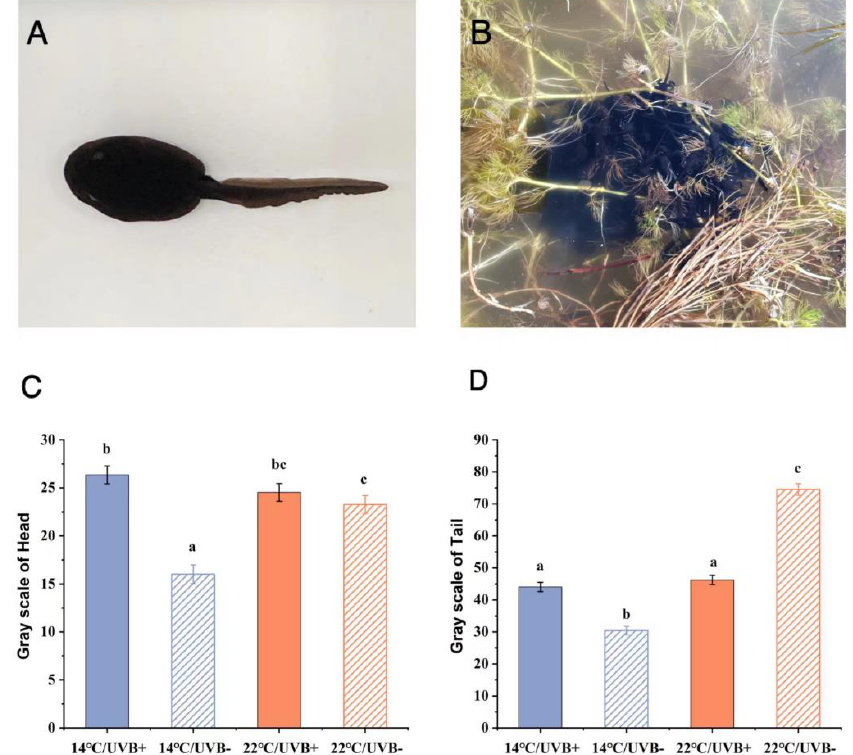
Figure 7. ( A ) Rana kukunoris tadpole in Stage G30. ( B ) Aggregation behavior of Rana kukunoris tad- poles in a wild pond. ( C , D ) Effect of UVBR (solid bars) and UVBR – free (patterned bars) environ- ments in combination with a 14 (blue bars) or 22 °C (red bars) temperature on the grayscale value of the head ( C ) and tail fin ( D ), respectively. Data are presented as means ± standard error. Lower- case letters above bars denote significant differences between groups. The color of the tadpole is expressed by grayscale, with a smaller gray value representing a darker body color. The grayscale value of both the head and the tail fin in the 14 °C/UVBR – free groups was significantly lower than that of the 14 °C/UVBR groups. However, under 22 °C exposure, the grayscale of the tail fin in the UVBR group was significantly lower than that in the UVBR – free group.